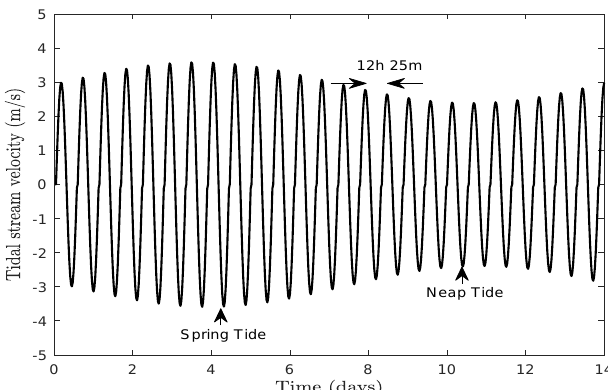
Figure 4. Tidal stream velocity profile at a typical tidal site experiencing semi-diurnal tides.